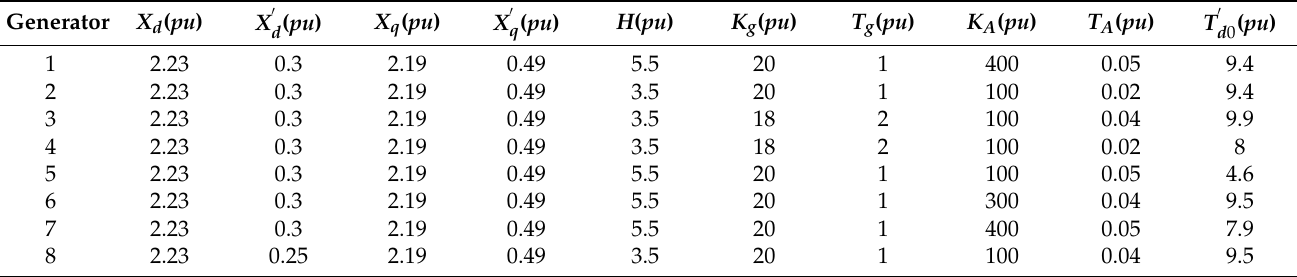
Table A2. Java-Indonesian grid generator data